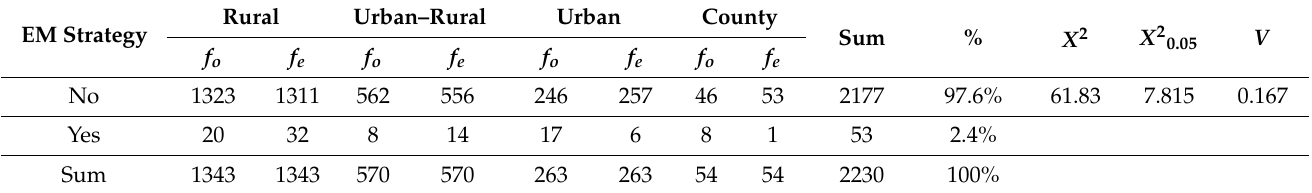
Table 1. Influence of the type of community (urban–rural) on the existence of a